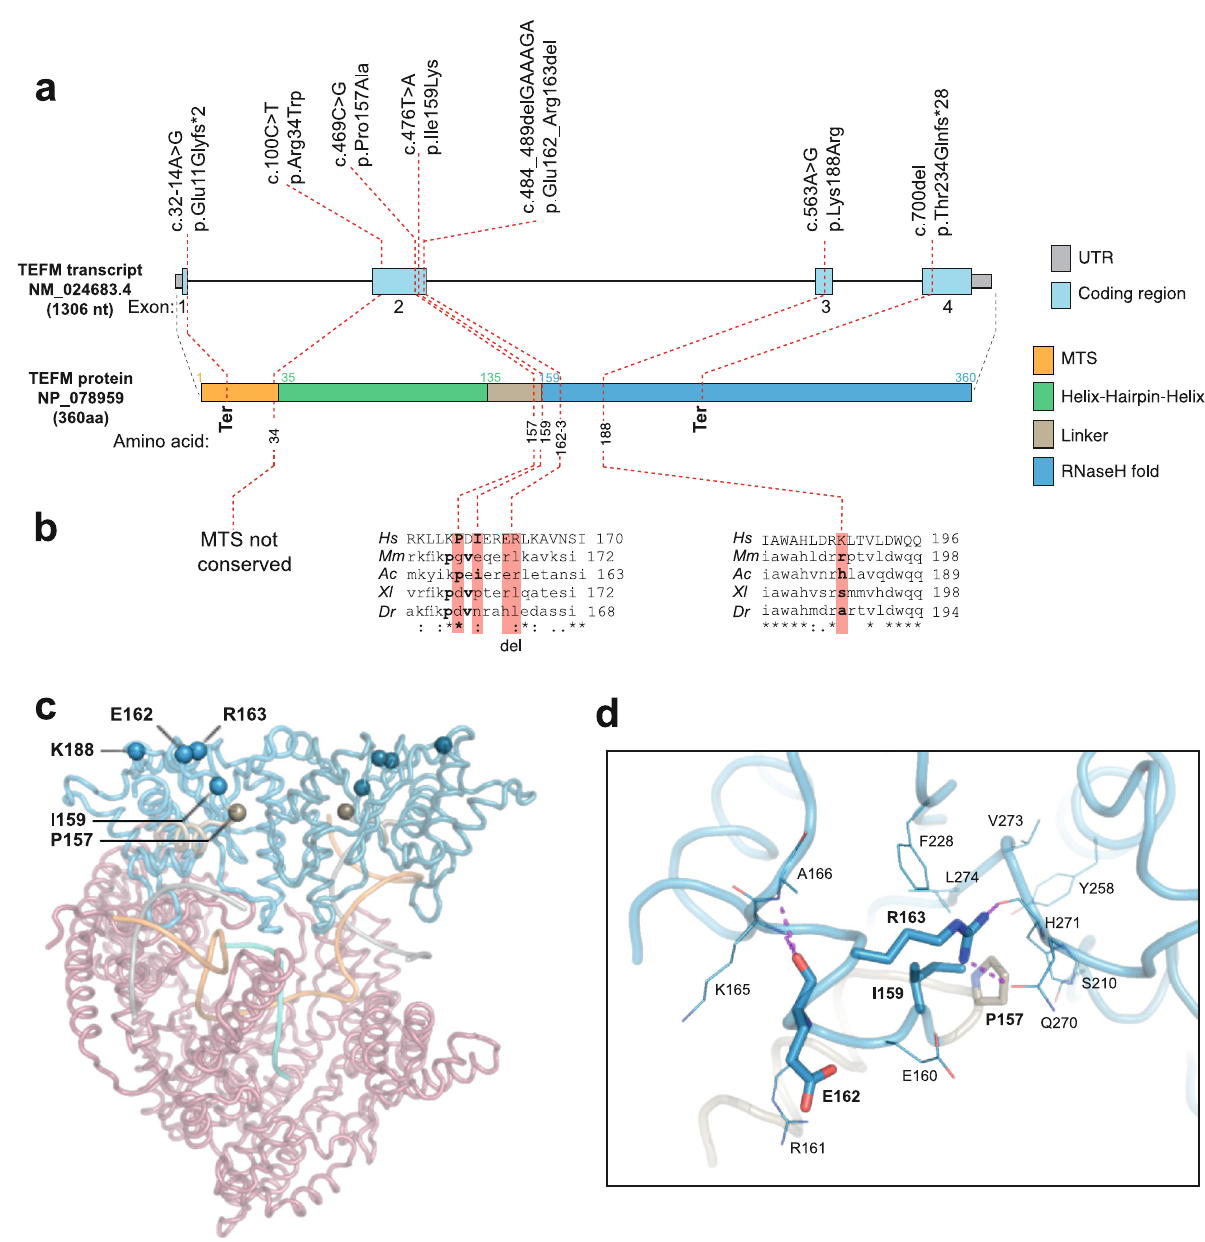
Fig. 3 | TEFM mutations and gene/protein structure. a Gene structure of TEFM with known protein domains of the gene product and localization of amino acid residues and splice site affected by mutations. The MTS (mitochondrial targeting sequence),theinter-domainlinkerandthetwoconservedfolddomains(RuvC-type RnaseH-folddomainandahelix – hairpin – helixmotif)areindicated. b Conservation